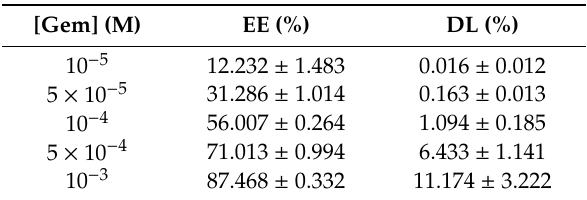
, γ + , and γ − are the Lifshitz-van der Waals, electron-acceptor, S S S